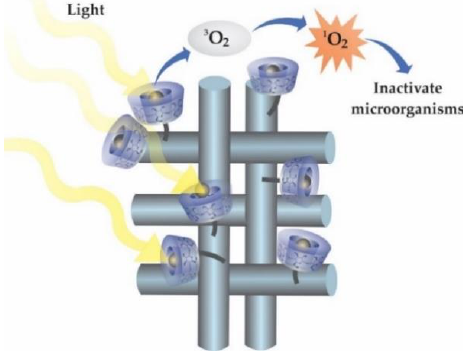
Figure 9. Finishing textiles with photodynamic potential.